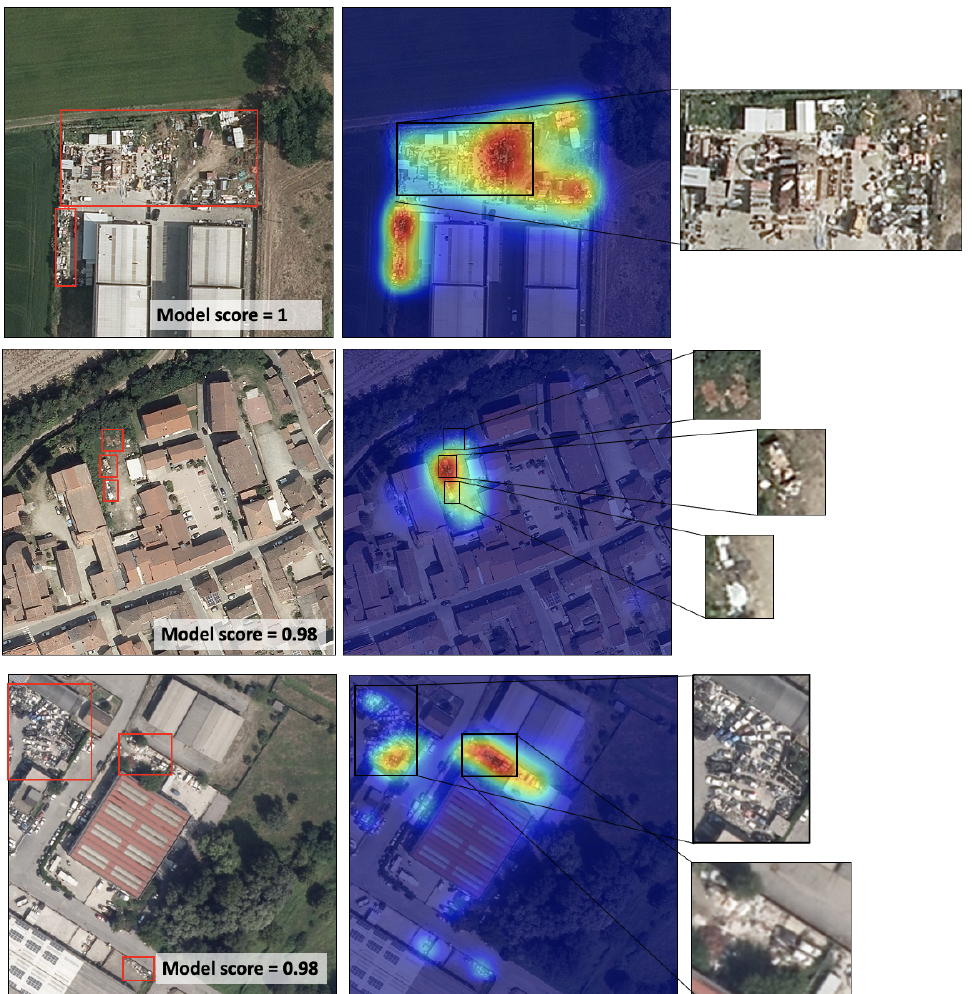
Figure 7. Examples of sites correctly classified a positive with high confidence. In each row, the left image is the input sample with one or more manually created bounding boxes surrounding the areas with waste. The center image shows the heat map derived from the CAM of the positive class. The right image zooms on the region where most of the waste